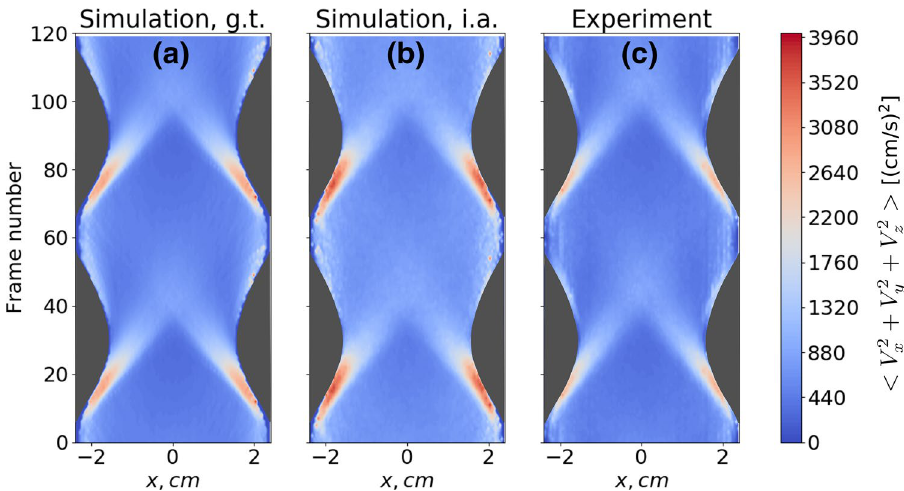
367 rods, the filling fraction is φ 2.0 % . ( a ) Ground truth Figure 8. Mean squared velocity profiles for N = = from the simulation, ( b ) reconstruction from the synthetic images of simulated data, ( c ) reconstruction using the experimental video from one of the parabolic flight experiments. Data were obtained by synchronous sampling over 200 cycles of the excitation. Dark gray regions correspond to the areas occupied by the